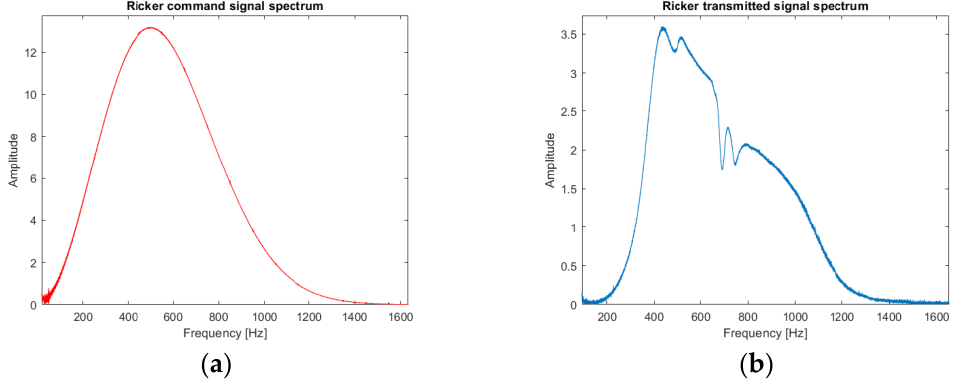
Figure 7. Example of the loudspeaker response (Ricker function): ( a ) theoretical source signal (red line); ( b ) experimental source signal sent by the loudspeaker through the pipe (blue line) recorded during the controlled experiment.